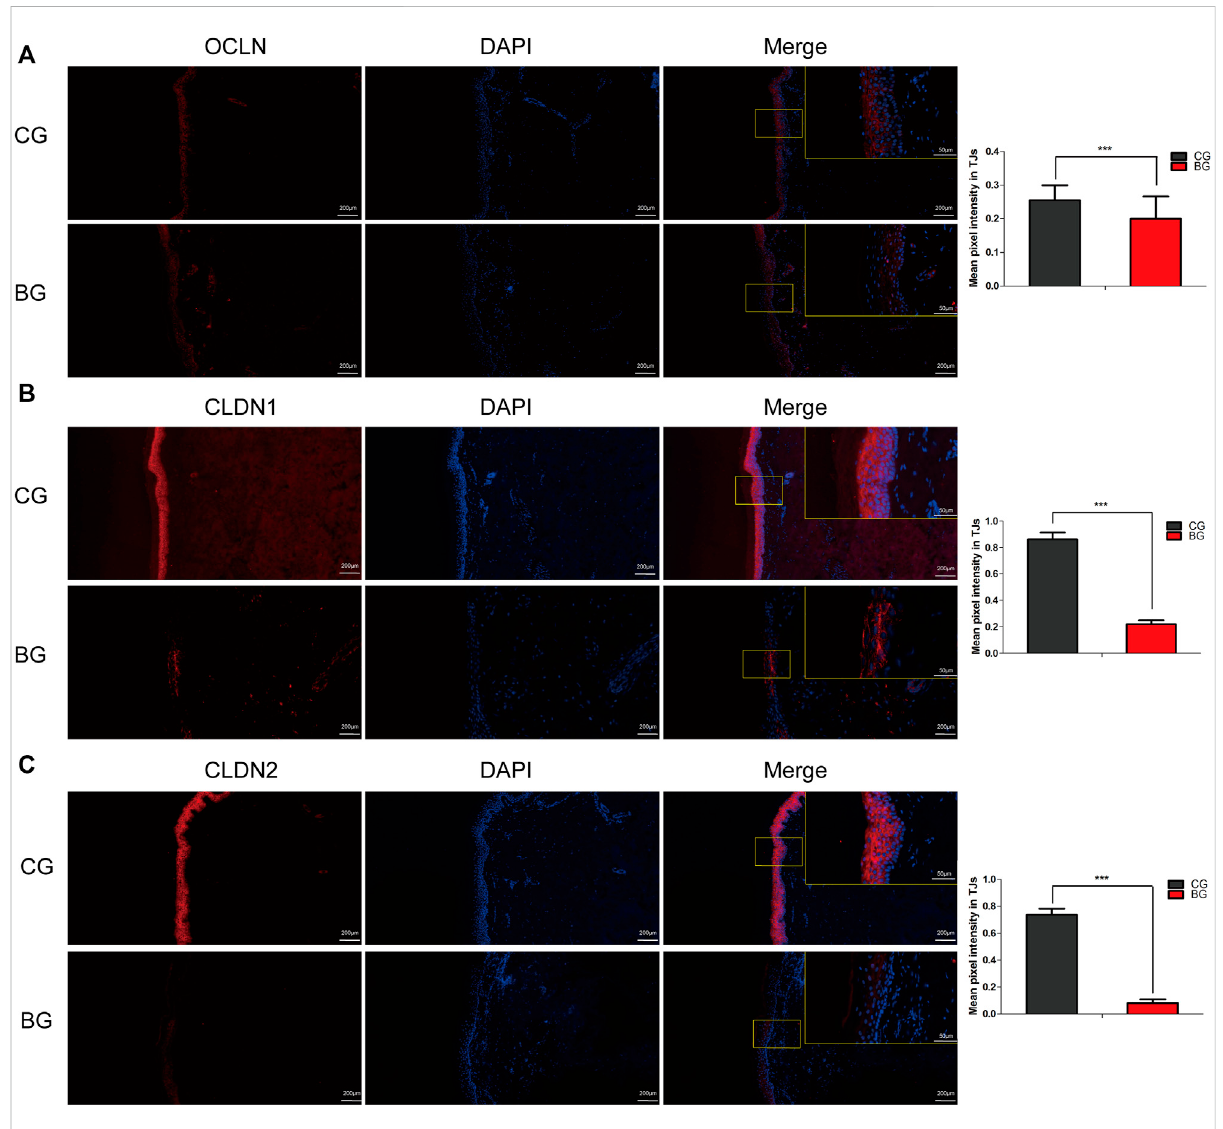
FIGURE 7 Immuno fl uorescenceimagesofoccludin,claudin1,andclaudin2innormalandblisteredskin.ThenucleiwerestainedwithDAPI(blue),andred fl uorescenceindicatesthelineage markers.TheOCLN (A) ,CLDN1 (B) ,andCLDN2 (C) levelsineachgroupwerecompared,anditwasillustratedthat the expression of these TJ markers decreased signi fi cantly in blister skin compared with normal skin. OCLN: occludin, CLDN1: claudin 1, CLDN 2: claudin 2. (Bars = 200 and 50 μ m, *: p < 0.05, **: p < 0.01, and ***: p <